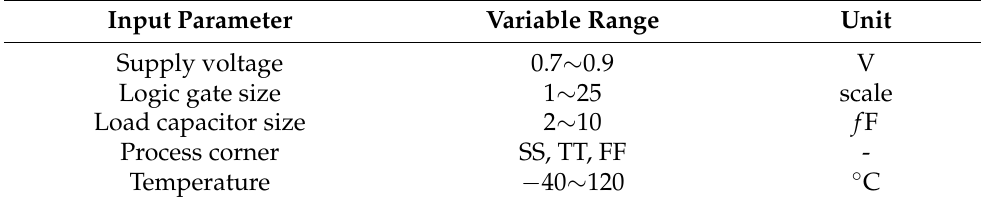
Table 6. Design input parameters of the asynchronous clock control